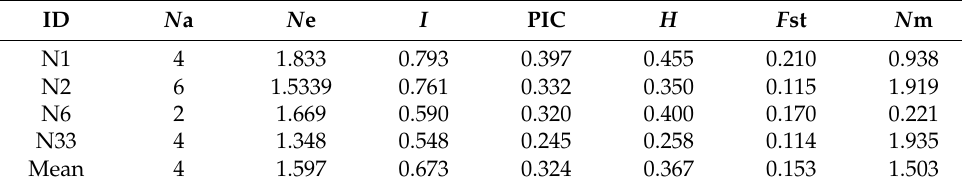
Table 3. Diversity statistics of the four cpSSR loci across 202 P. orientalis